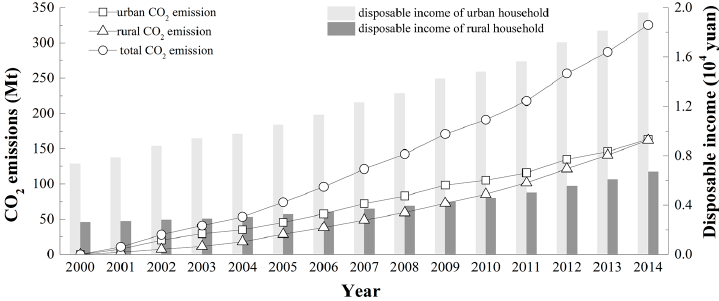
Figure 6. Accumulated changes in income level effect on household CO 2 emissions and income level in China (2000–2014).